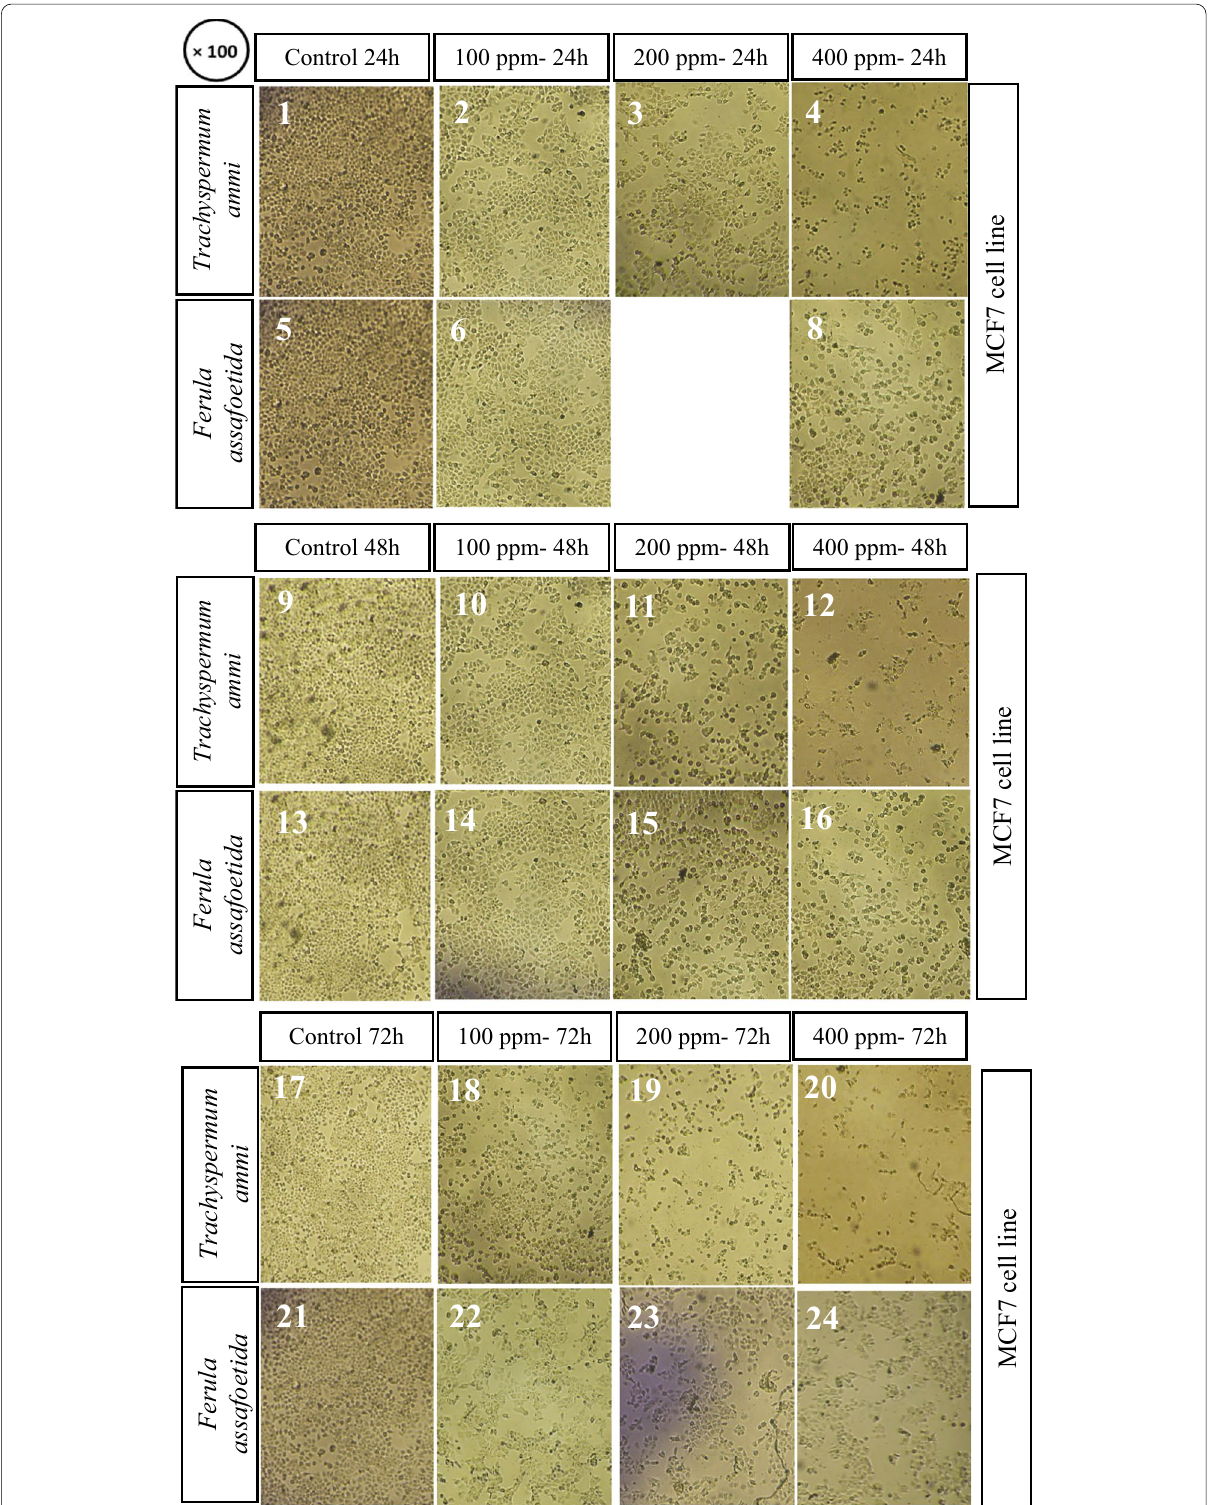
Fig. 2 Morphological changes of MCF-7 (1–24) and MDA-MB-468 (25–48) cell lines in exposure to Trachyspermum ammi essential oil (TAEO) and Ferula assafoetida essential oil (FAEO) after 24, 48, and 72 h of